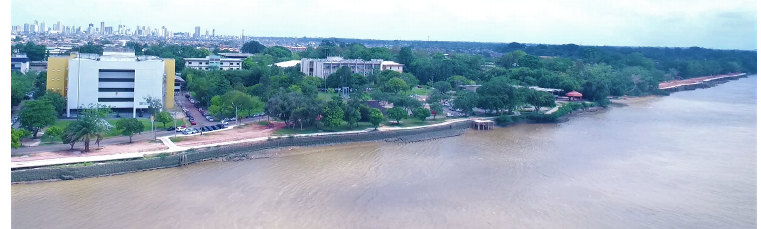
Figure 2. UFPA Campus.